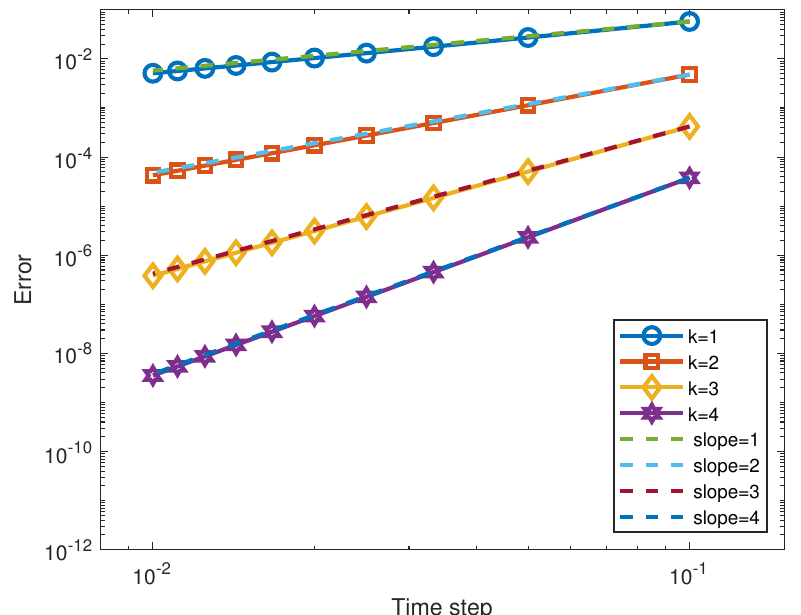
Figure 1. Errors of k -step exponential multistep method for problem (23). k = 1,2,3,4. D = σ = a = b = c =